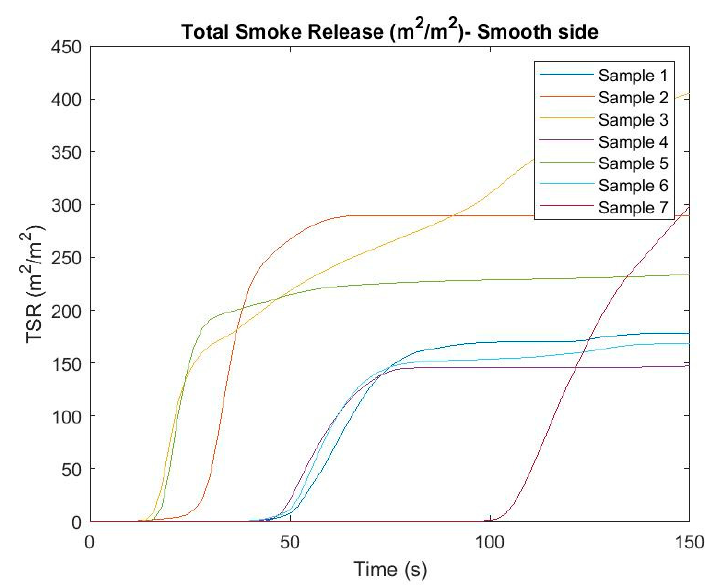
Figure 3. Total smoke release (m 2 /m 2 ) in time—smooth side.